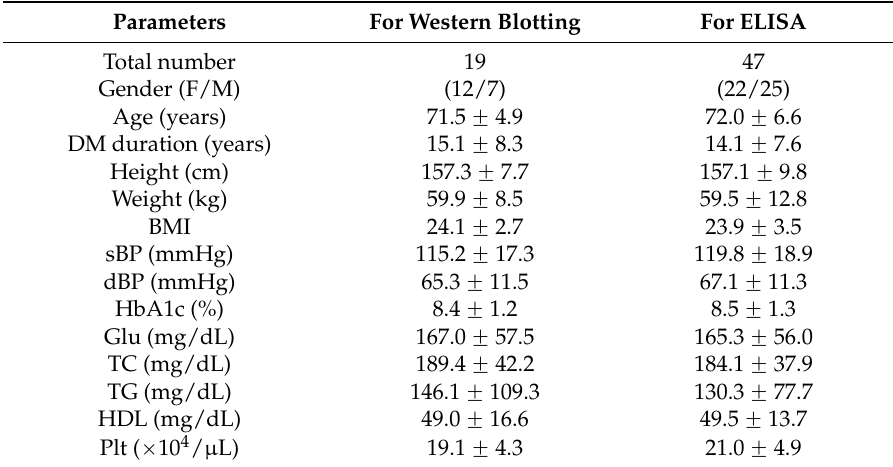
Table 1. Characteristics of the study